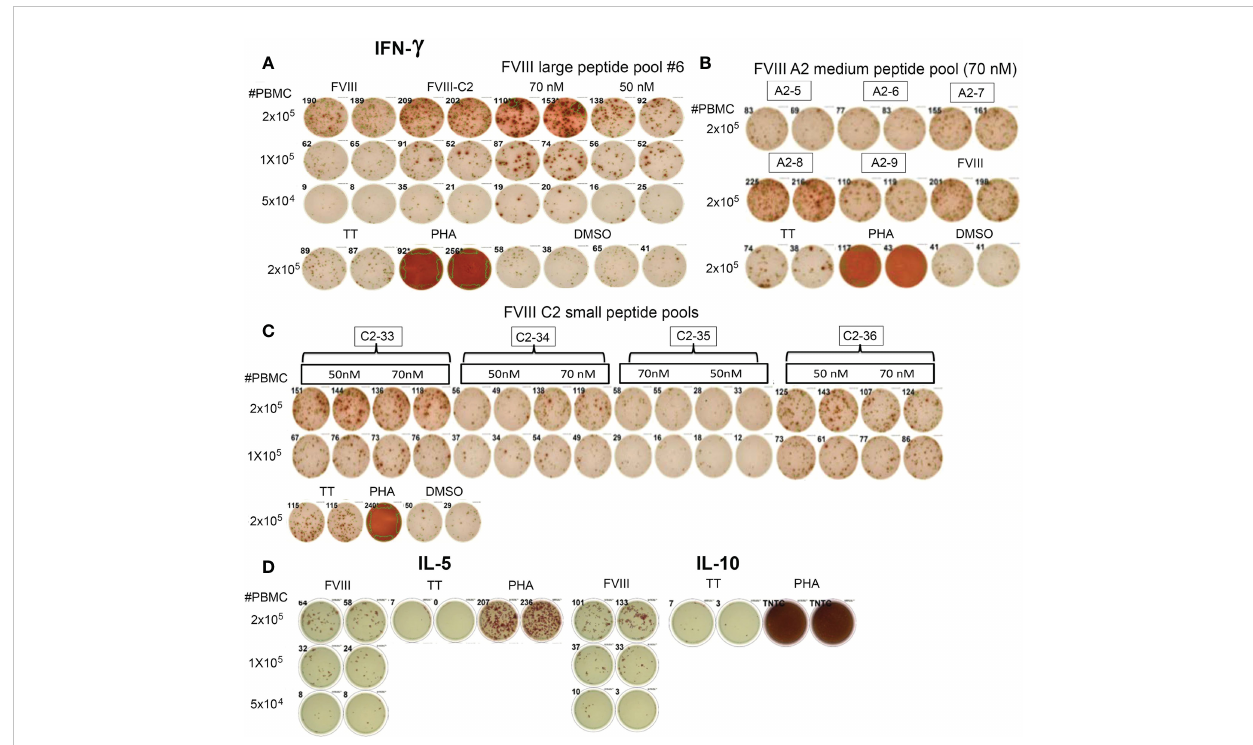
FIGURE 3 CD4 + T cells from Int22Inv subject P11 respond to epitopes in the FVIII A2 and C2 domains. (A) He showed a strong IFN- g response to rFVIII, rFVIII- C2 protein, and FVIII large peptide pool #6 (which contained peptides spanning the C2 domain sequence). (B) His PBMCs also responded to FVIII A2 domain medium peptide pools A2-7, A2-8 and A2-9. (C) Decoding of his response to rFVIII-C2 protein and FVIII large peptide pool #6 by stimulating his PBMCs with small peptide pools spanning the FVIII C2 domain sequence. His PBMCs responded to epitopes in pools C2-33, C2-34 and C2-36. (D) This subject also showed Th2 (IL-5) and Tr1 (IL-10) responses to rFVIII stimulation. His responses to multiple epitopes in the A2 and C2 domains indicate that the inverted F8 mRNA containing exons 1-22 and F8B mRNA (encoding the putative FVIIIB protein containing the FVIII C2 domain sequence) did not confer tolerance to the FVIII A2 or C2 domains. TT = tetanus toxoid. PHA = phytohemagglutinin. Negative control: DMSO (5 m l/well). rFVIII: 5 nM, rFVIII-C2: 50